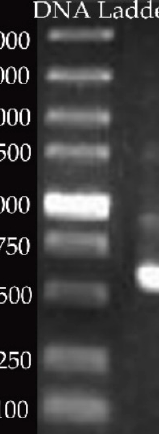
Figure 2. Genotyping analysis via rep-PCR uses ERIC primers. Using the primer pair ERIC1R/ERIC2, strain of Paenibacillus larvae ( P. larvae ) was analyzed. The left band is the DNA ladder (bp), the right two bands (“1” and “2”) are the replicates of P. larvae . The bands migrating at 970 bp and 2800 bp, considered specific for ERIC Ⅱ , are highlighted by